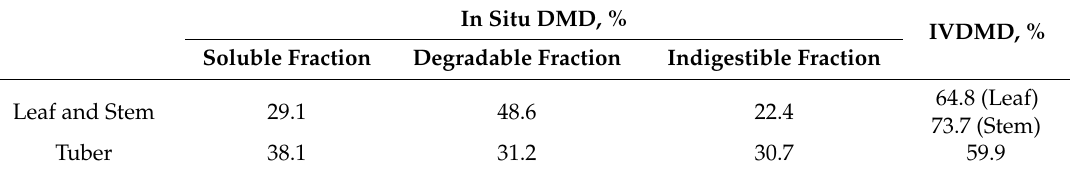
Table 5. In situ dry matter disappearance (DMD) and in vitro dry matter digestion (IVDMD) of kudzu ( P. montana ) plant parts [20].